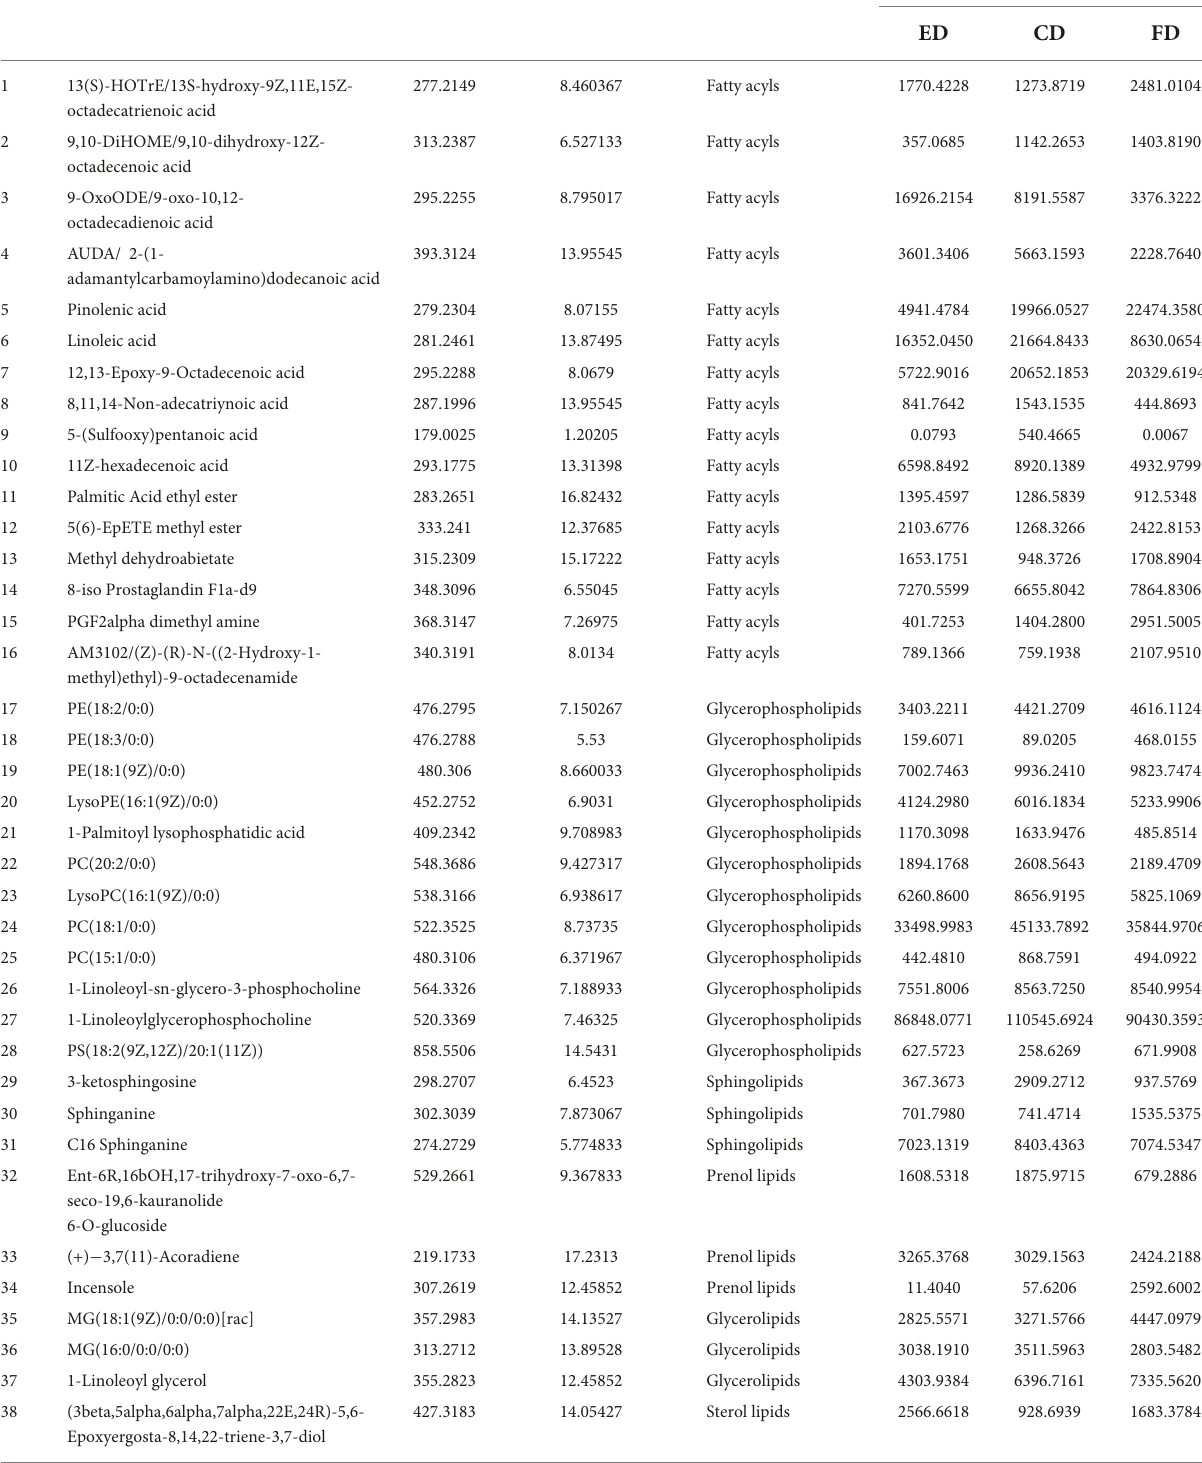
TABLE 2 Differential metabolites identification of different drying